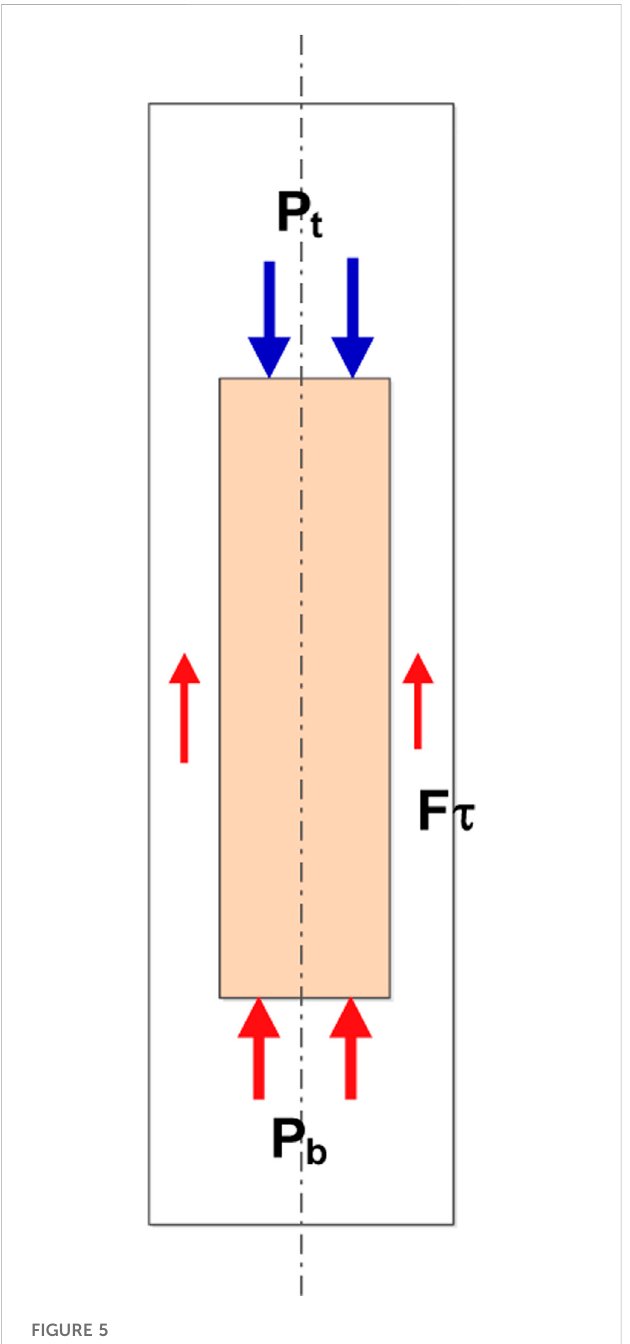
FIGURE 5 Forces applied on